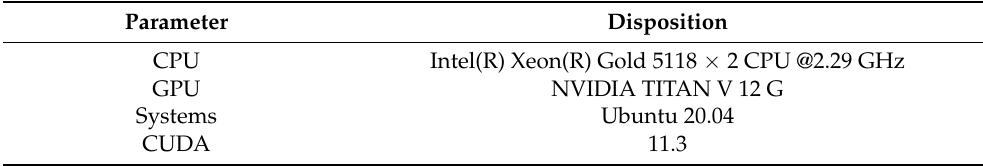
Table 1. Experimental parameter configuration.